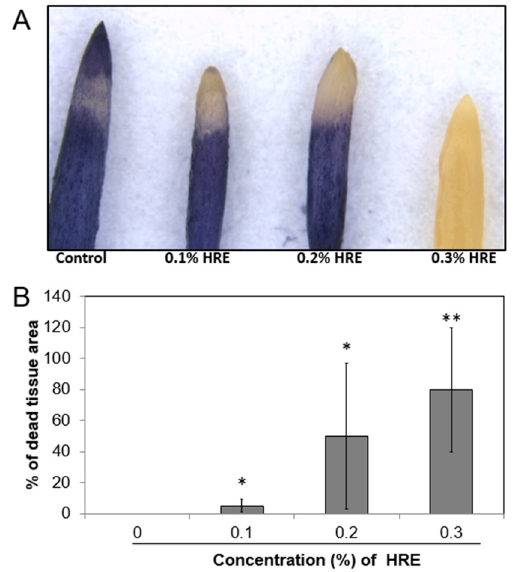
Figure 4. Nitroblue tetrazolium staining (ROS accumulation) of onion root tips ( A ) and dead tissue area after 3 days of treatment with various HRE concentrations ( B ). * and ** indicate significant difference from control by Student’s t -test at p = 0.01 and p = 0.001, respectively. HRE, horseradish extract.